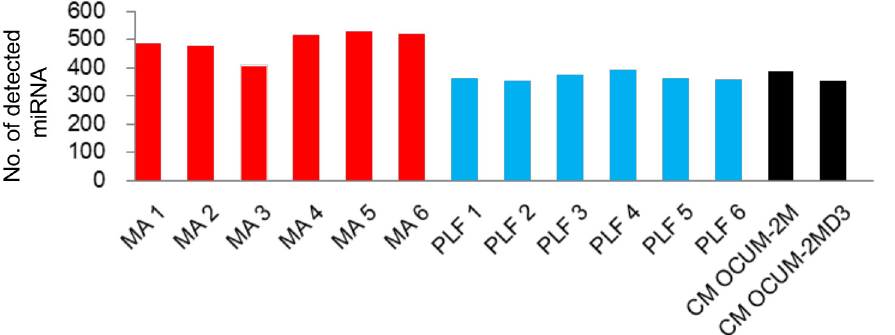
Fig 2. The number of detected miRNA species in 14 samples.